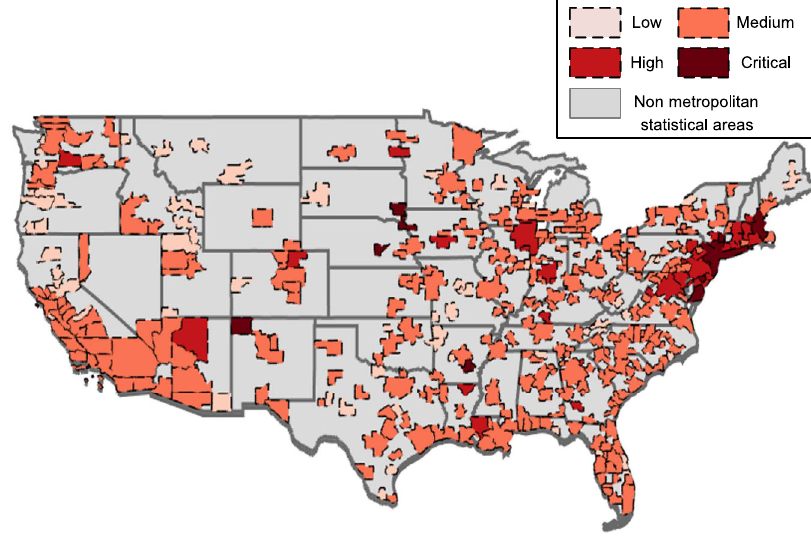
Fig. 1 | COVID-19 incidence map. COVID-19 Incidence map of 380 metropolitan statistical areas in the continental U.S. during April – May 2020.